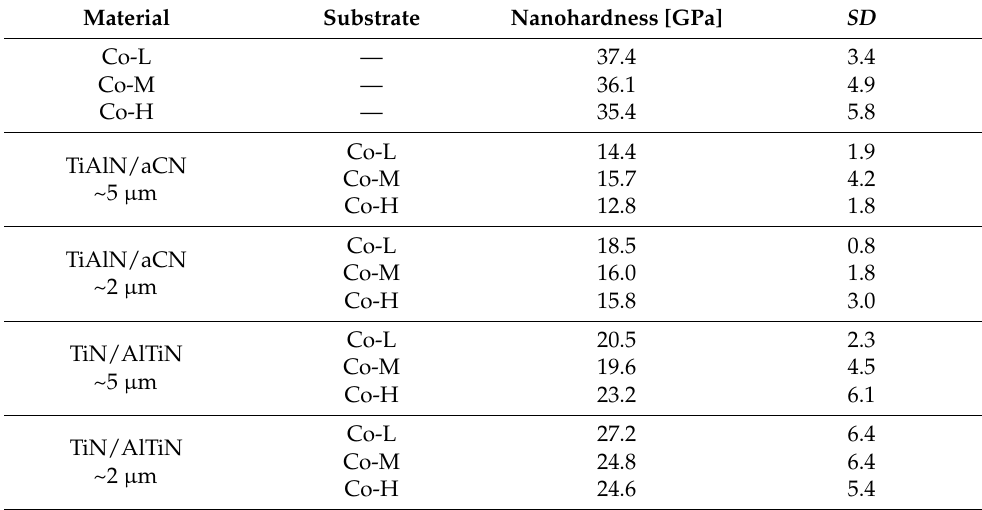
Table 6. Nanohardness of TiN/AlTiN and TiAlN/a-C:N coatings deposited on different substrates.